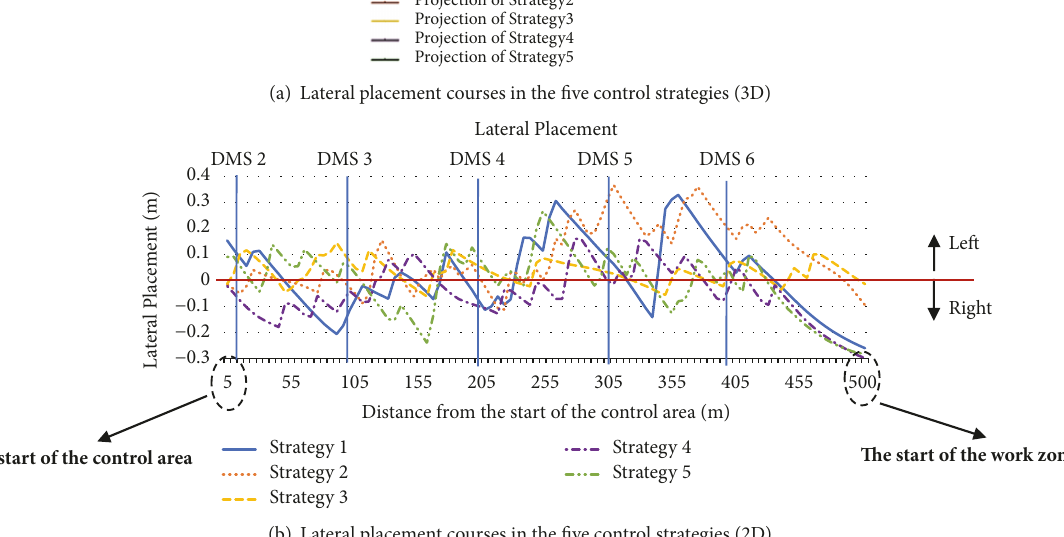
Figure 9: Lateral placement courses in the five control